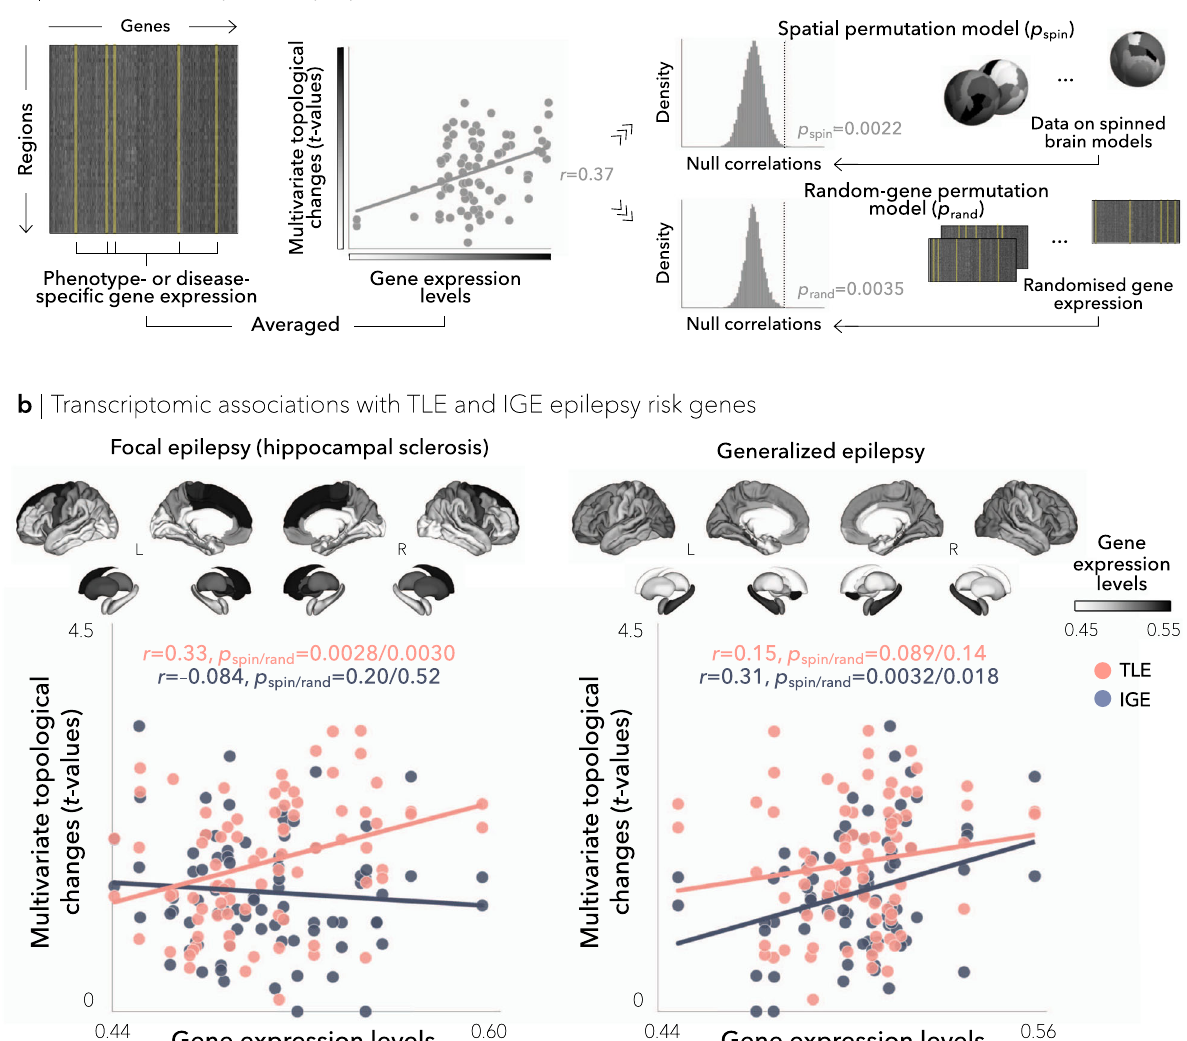
Fig. 3 Imaging-transcriptomic associations. a Schematic of the approaches for statistical testing of imaging-transcriptomic associations. Gene expression data for a subset of phenotype- or disease-speci fi c genes are averaged and spatially compared to the patterns of multivariate topological changes in TLE and IGE independently. Spatial correlations are statistically assessed using one-tailed, non-parametric tests: (i) spatial permutation models, which preserve the spatial autocorrelation of brain maps ( p spin ; 10,000 permutations), and (ii) permutation models, which generate null distributions from randomised gene expression data with identical length as the original gene set ( p rand ; 10,000 permutations). b Gene expression levels associated with two distinct epilepsy subtypes (focal epilepsy with hippocampal sclerosis and generalized epilepsy) were mapped to cortical and subcortical surface templates and spatially compared to patterns of multivariate topological alterations (which combined clustering and path length; see Fig. 2) across cortical and subcortical regions ( n = 82) using one-tailed, non-parametric tests. In TLE, spatial associations between microarray data and multivariate topological changes were strongest for expression levels of hippocampal sclerosis genes ( r = 0.33, p spin = 0.0028). On the other hand, in IGE, spatial associations were strongest for expression levels of generalized epilepsy genes ( r = 0.31, p spin = 0.0032). Both TLE- and IGE-speci fi c imaging-transcriptomic associations were robust against null distributions of effects based on selecting random genes from the full gene set (TLE: p rand = 0.0030, IGE: p rand = 0.018). HC = healthy control, IGE = idiopathic generalized epilepsy, TLE = temporal lobe epilepsy, p spin = p -value corrected against a null distribution of effects using a spatial permutation model, p rand = p -value corrected against a null distribution of effects using a “ random-gene ” permutation